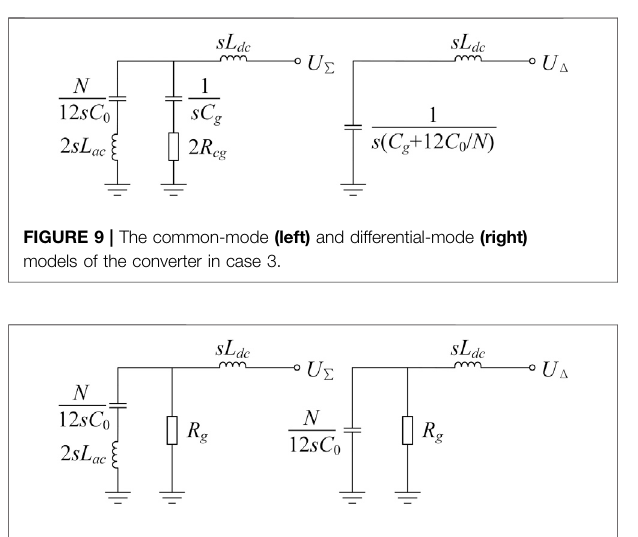
FIGURE 10 | The common-mode (left) and differential-mode (right) models of the converter in case 4.